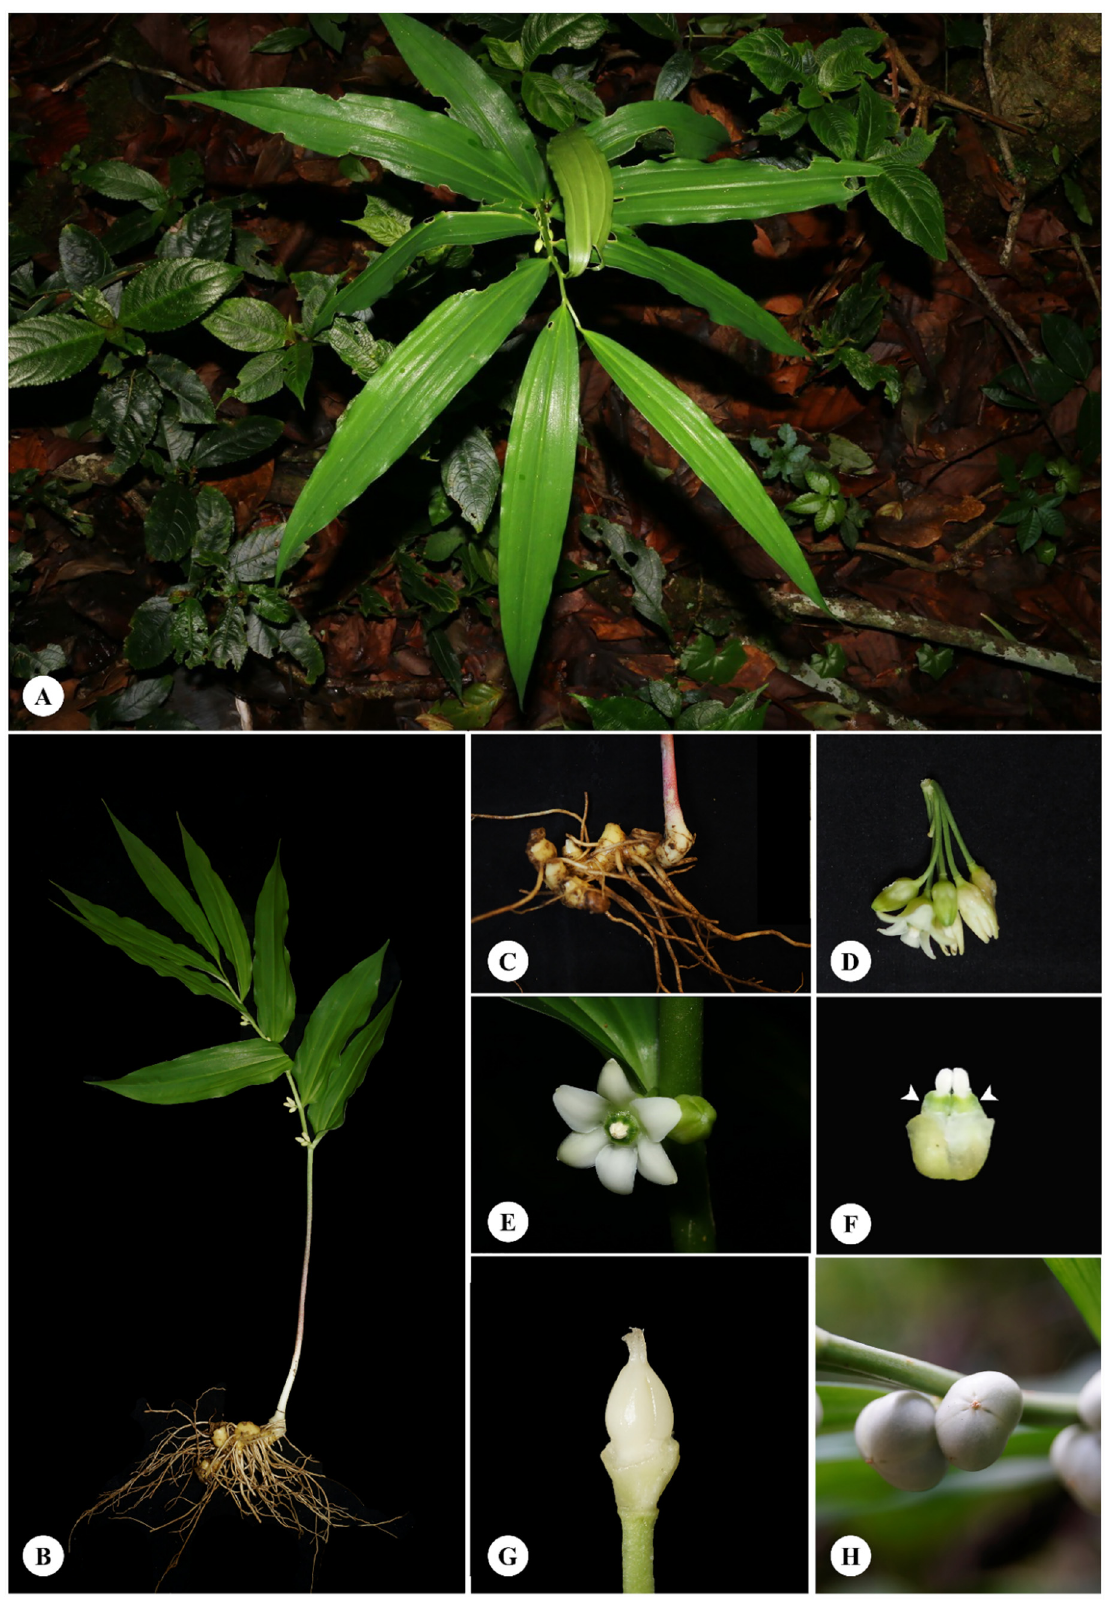
Figure 1. Morphological features of Disporopsis longifolia. ( A ) Habit; ( B ) whole plant; ( C ) moniliform rhizome; ( D ) fascicle flowers; ( E ) flowers; ( F ) stamen and corona (arrowheads); ( G ) pistil; ( H ) fruits. Specimen: Chiang Mai, A. Sarapan 41 . Photos by A. Sarapan.